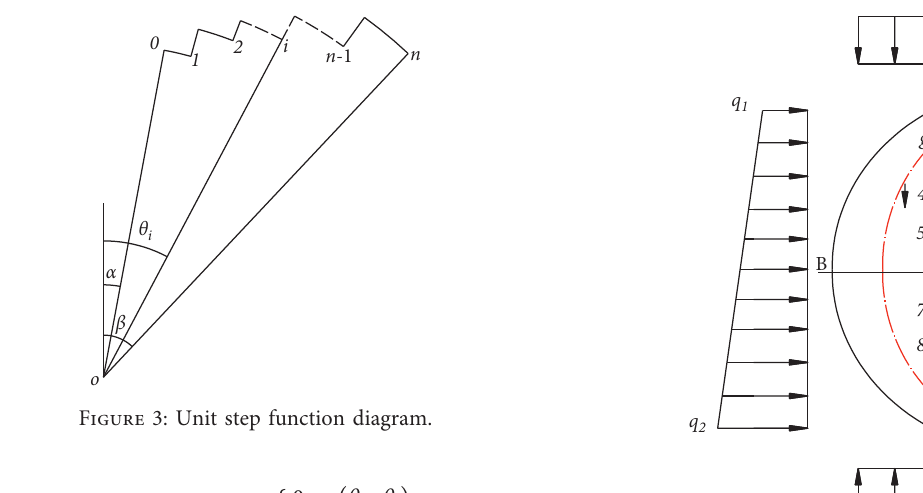
Figure 4: Basic structure of inner contour stepping